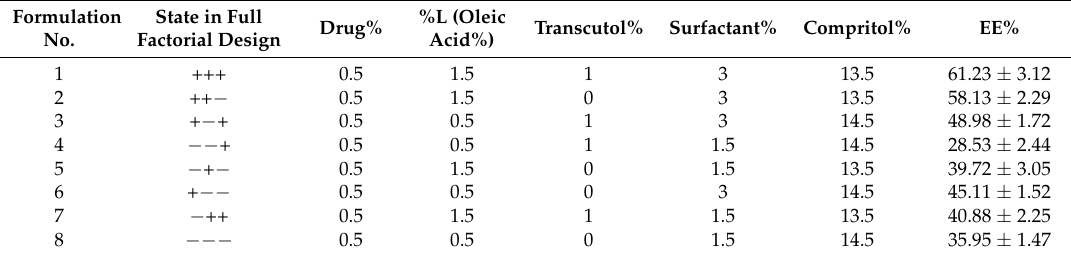
Table 1. Formulation characterizations for propranolol hydrochloride nanostructure lipid carrier (NLC) according to full-factorial design and entrapment efficiency (EE%) (all concentrations are presented as w / v % and referred to total volume of